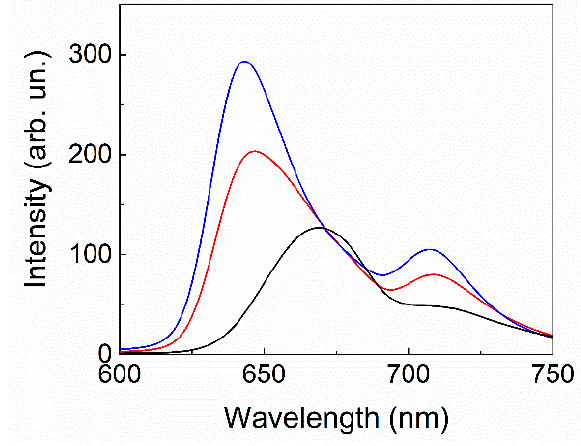
Figure 3. Fluorescence emission spectra comparison among the initial H 2 TPPS 44 − (blue trace), after the addition of NaCl (red trace) and the H 4 TPPS 42 − (black trace). Experimental conditions: [H 2 TPPS 44 − ] = 3 μ M; [HCl] = 0.3 M; [NaCl] = 0.2 M; λ ex = 420, T = 298 K.